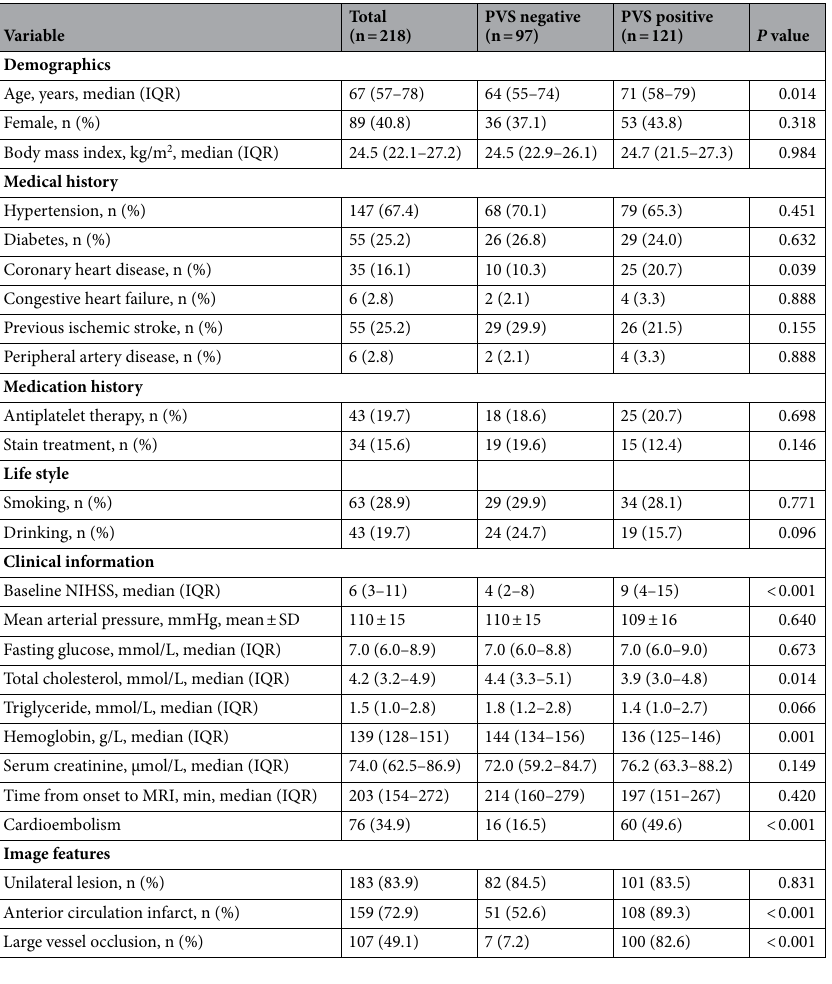
Table 1. Univariate analysis to identify factors associated with prominent vessel sign. IQR interquartile range; NIHSS National Institutes of Health Stroke Scale; PVS prominent vessel sign; SD standard deviation.